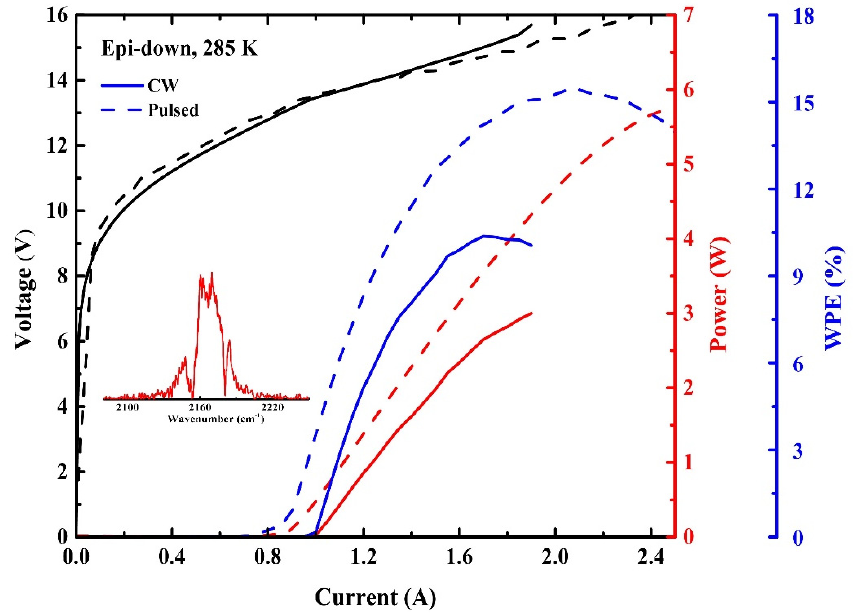
Figure 4. Continuous wave (solid lines) and pulsed (dashed lines) P-I-V and WPE characterization for a 8 mm-long and 7.5 µ m-wide QCL device. The inset shows the lasing spectrum in CW mode.